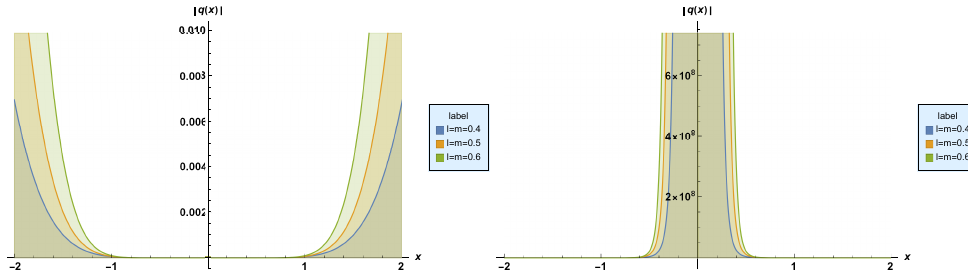
Figure 7. Profiles of stationary dark and singular solitons, respectively.